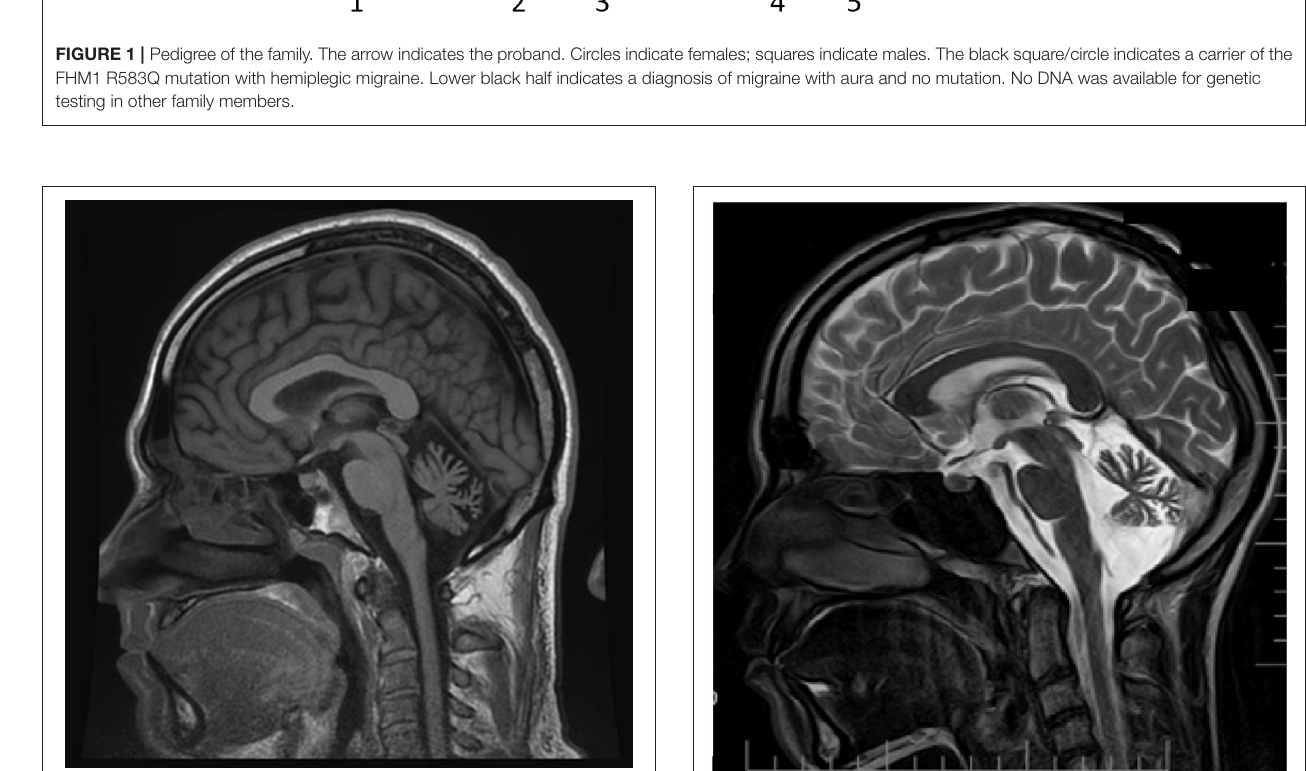
Patient S (Son), 17-Years-Old at Diagnosis